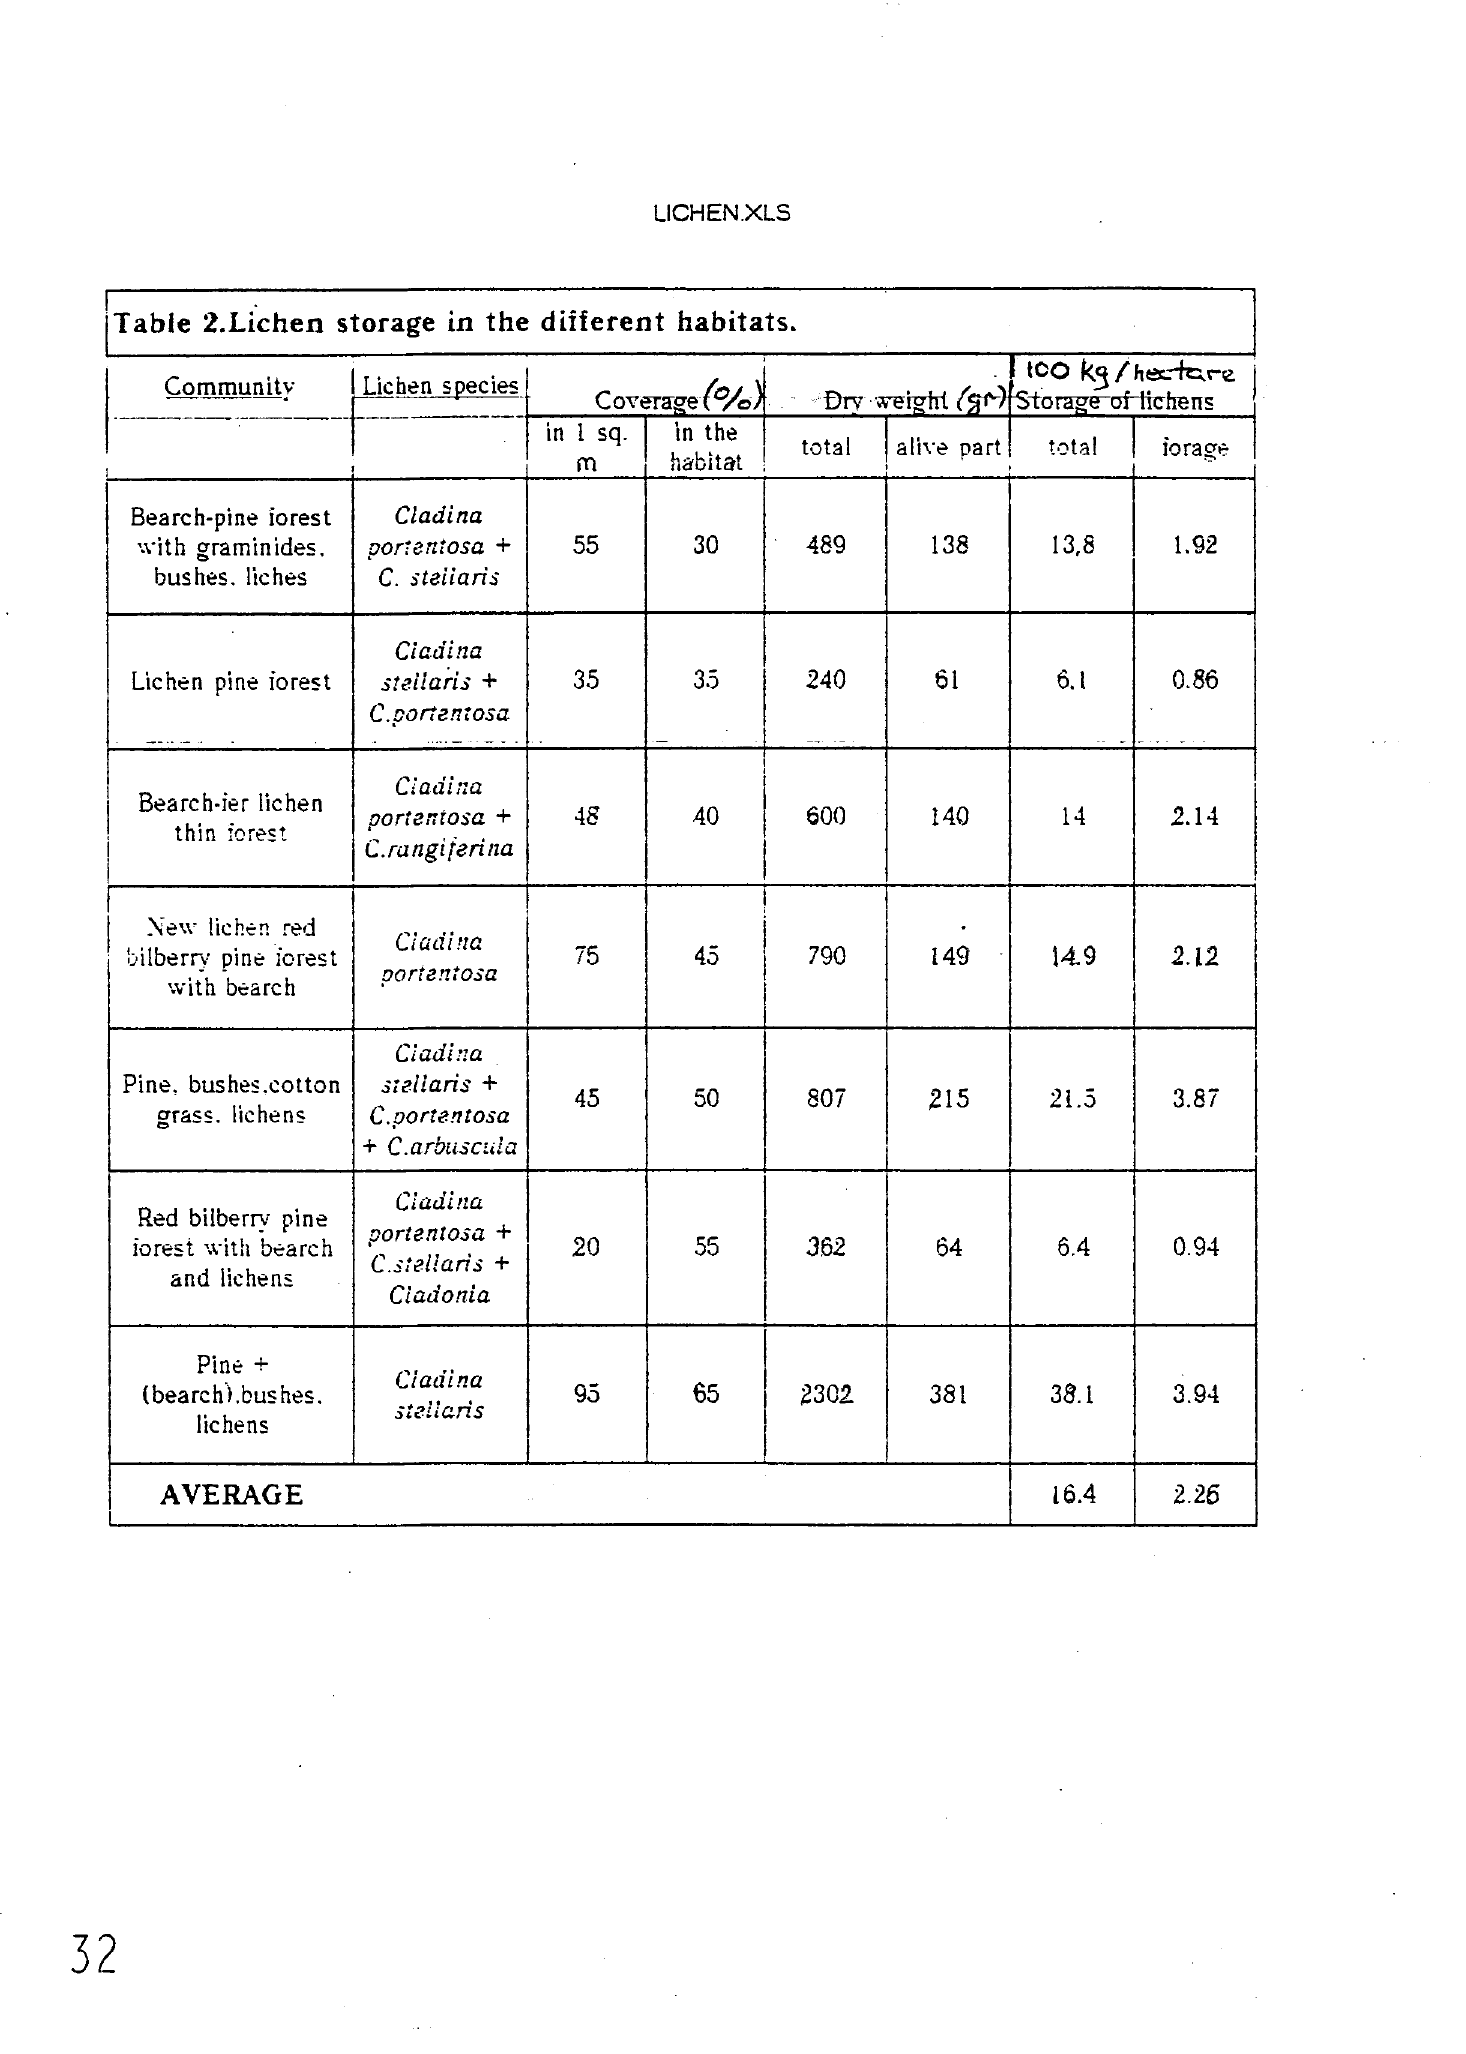
tCO kg/hecrfcr-e "Storagerof lichens